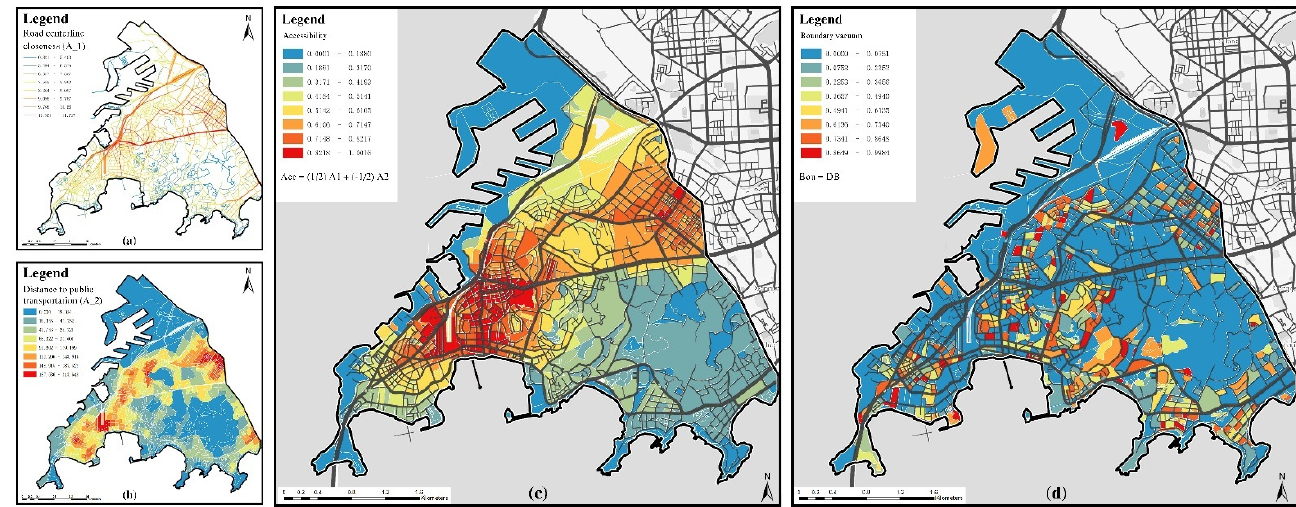
Figure 8. Accessibility and boundary vacuum analysis. (a) Road centerline closeness. (b) Distance to public transportation. (c) Accessibility composite index. (d) Distance to boundary vacuum. public transportation. ( c ) Accessibility composite index. ( d ) Distance to boundary